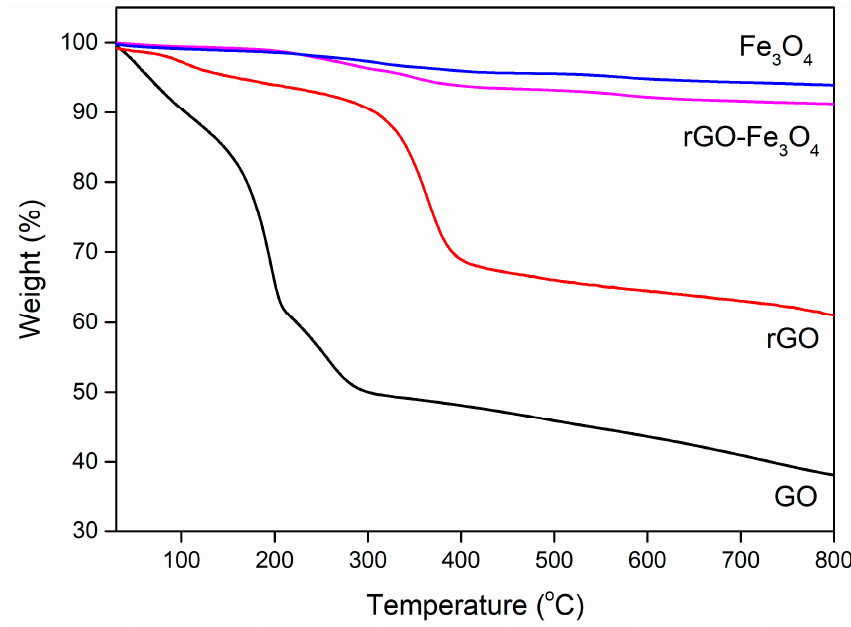
Figure 4. Thermogravimetric analysis curves of GO, rGO, Fe 3 O 4 , and rGO–Fe 3 O 4 nanocomposites.